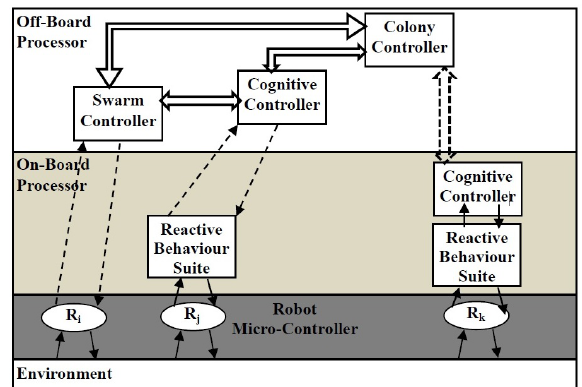
Figure 3: Architecture Schematic with more sophisticated robots to the right of figure. Single arrows represent control and information flow. Walled arrows represent information flow. Dashed lines represent communication over the network. Solid lines represent communication within a processor.